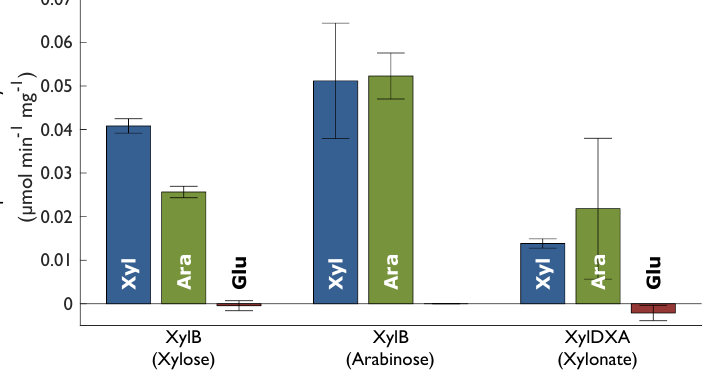
Figure 3. Enzyme activity in crude cell extract form C. crescentus grown on xylose (Xyl), arabinose (Ara) or glucose (Glu). Xylose dehydrogenase (XylB) was assayed with both xylose and arabinose as substrate and the compound activity of three enzymes (XylDXA), xylonate dehydratase (XylD), 2-keto-3-deoxyxylonate dehydratase (XylX) and α -ketoglutarate semialdehyde dehydrogenase (XylA). Substrates are indicated within round brackets. Error bars represent standard